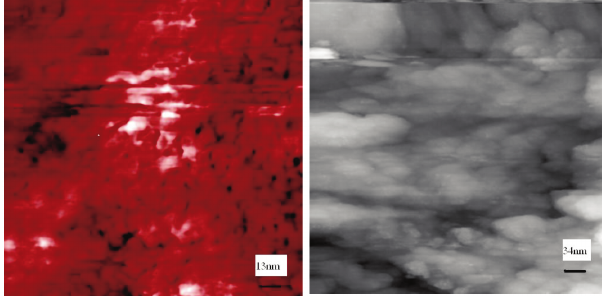
by Scanning Tunneling 2